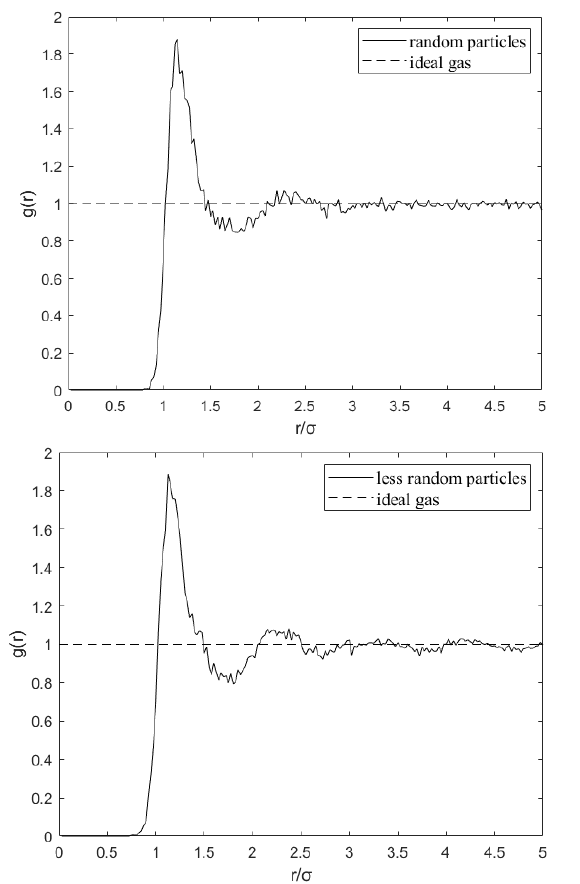
Figure 1. Radial distribution function of randomly distributed aggregate and aggregate particles which are random with spatial constraints. The random distribution with spatial constraints shows more prominent oscillations about 1, the benchmark ideal gas molecule random arrangement, which illustrates the emergence of some characteristic spacings in the coarse aggregate